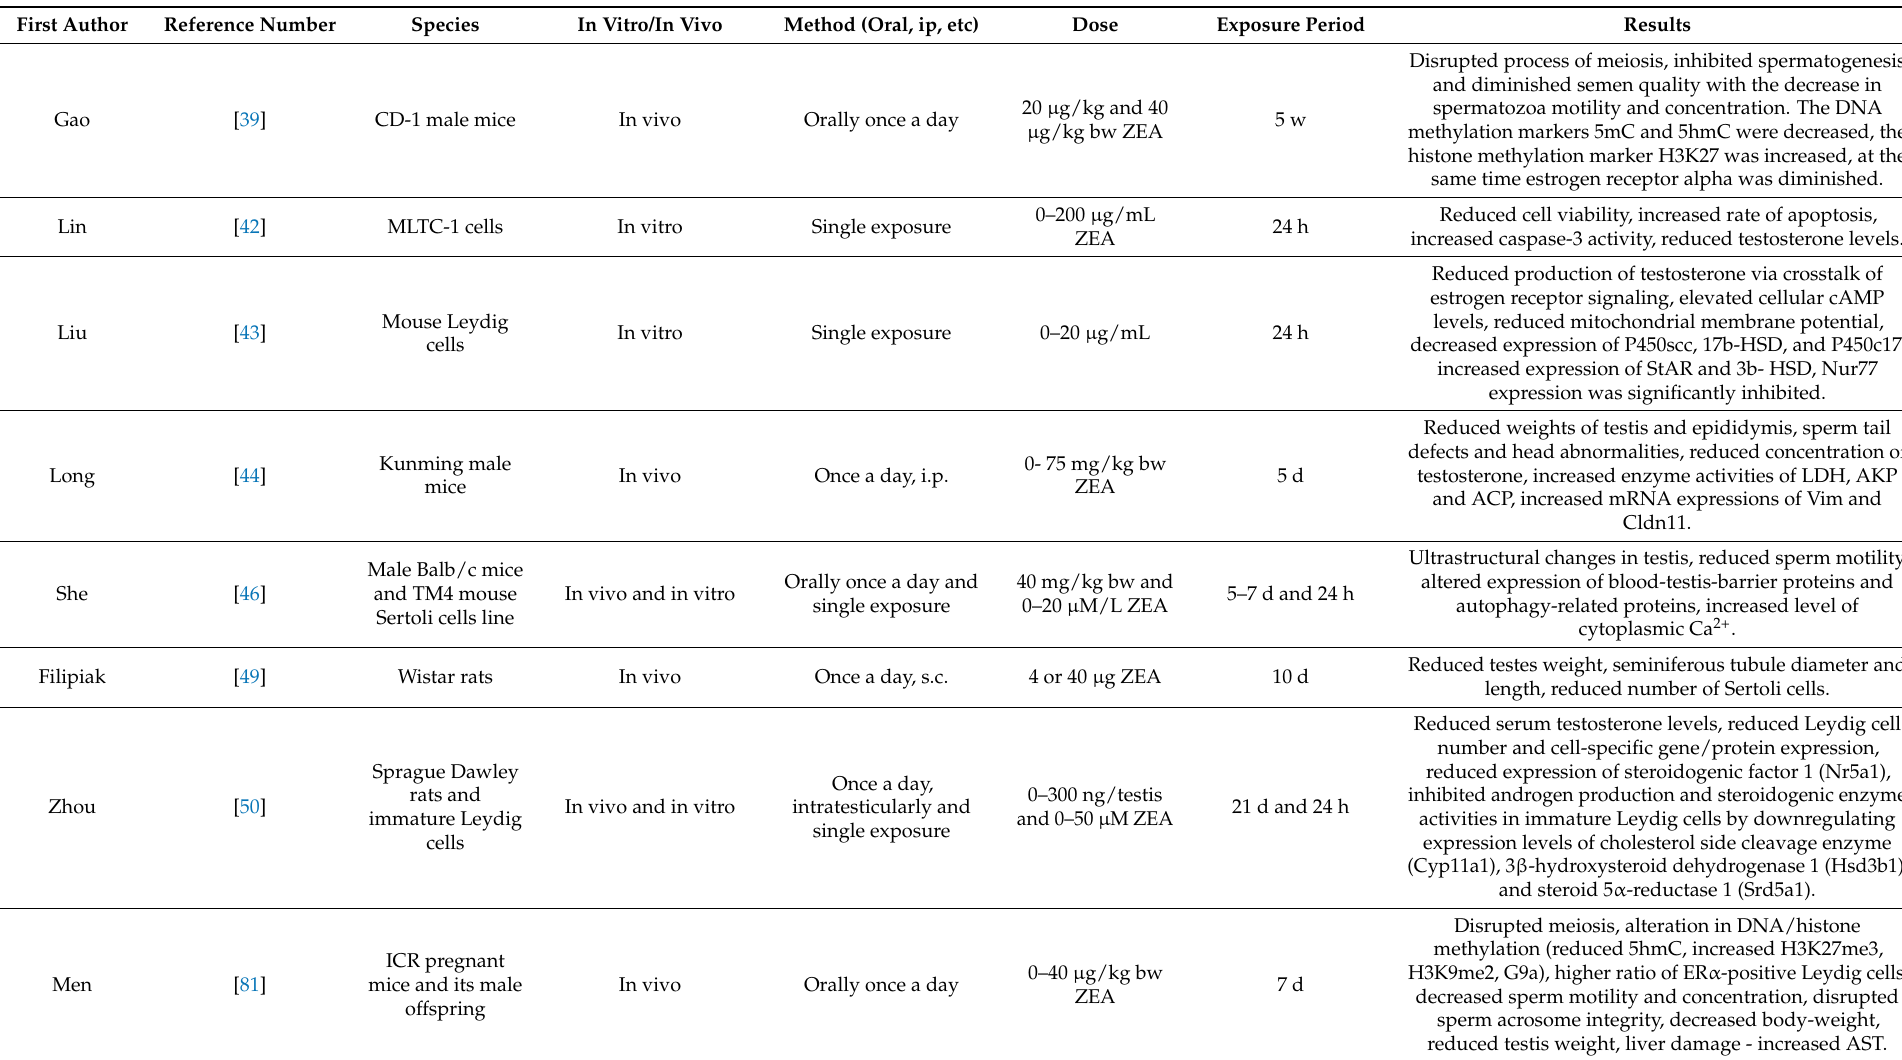
Table 1. Main data characteristic of reviewed studies which deal with estrogen-dependent